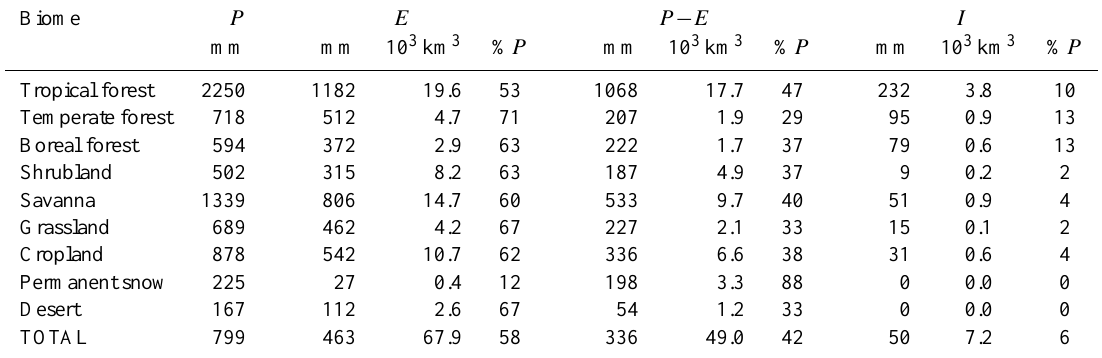
Table 3. Annual precipitation ( P ), evaporation ( E ), water available for runoff ( P − E ) and rainfall interception loss ( I ) per biome type for